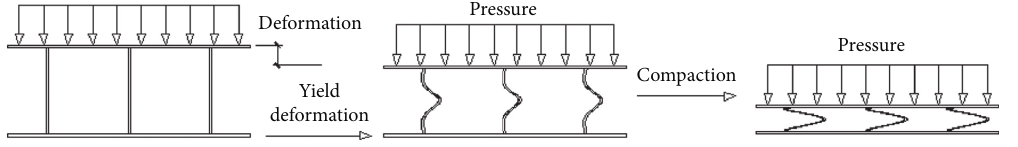
Figure 3: SRLD working process.